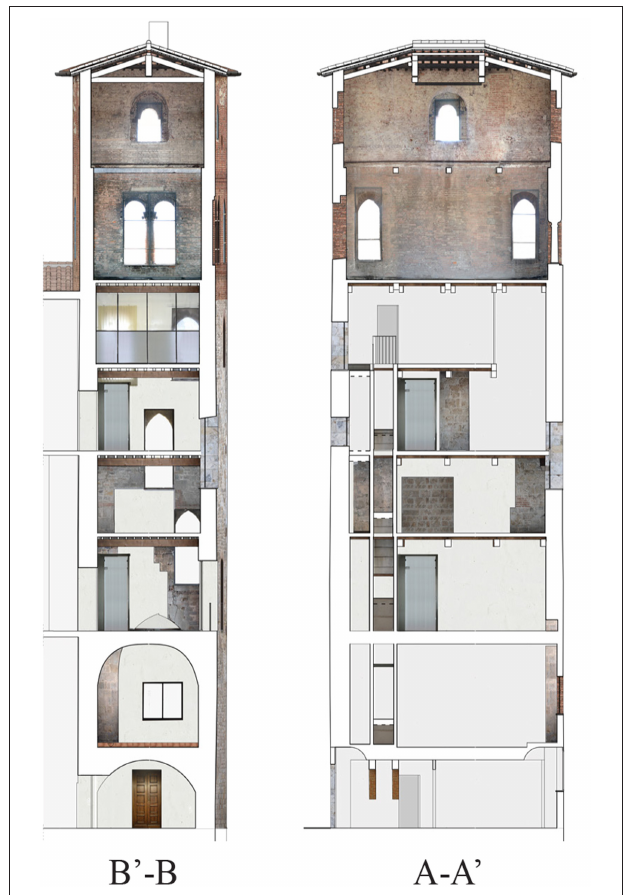
FIGURE 3 | Sections of the Lanfreducci Tower.